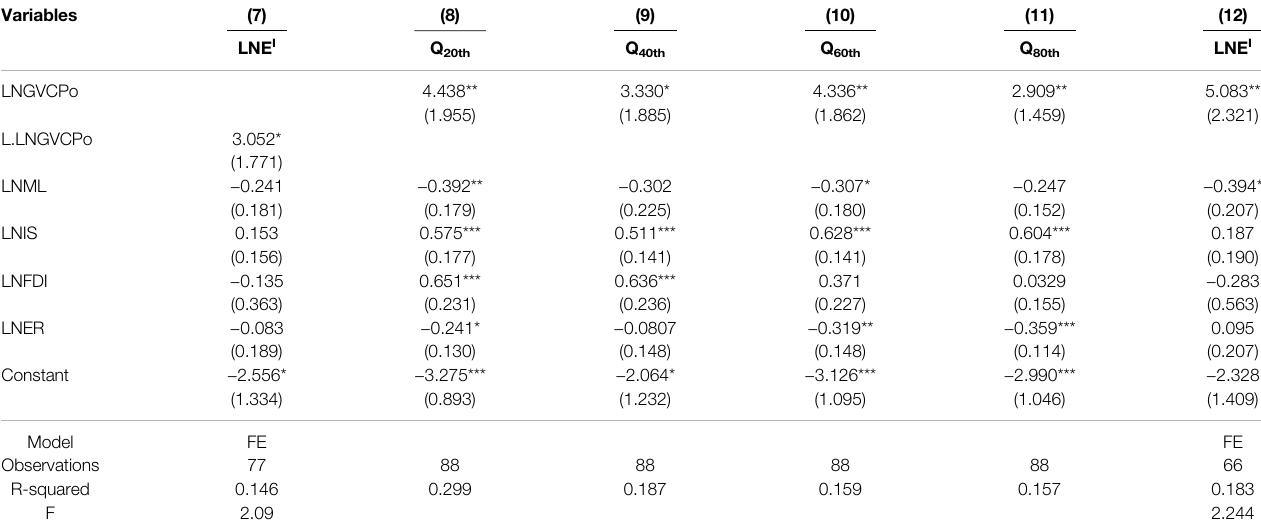
TABLE 4 | Regression results of endogenous issue and robustness test.